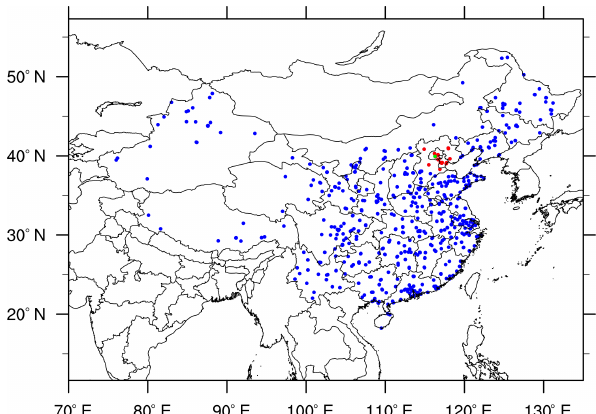
Figure 1. Computation domain. Dots depict surface observations with 531 stations spreading over China. The red dots indicate the observations around Beijing. The green dot indicates the IUM sta-